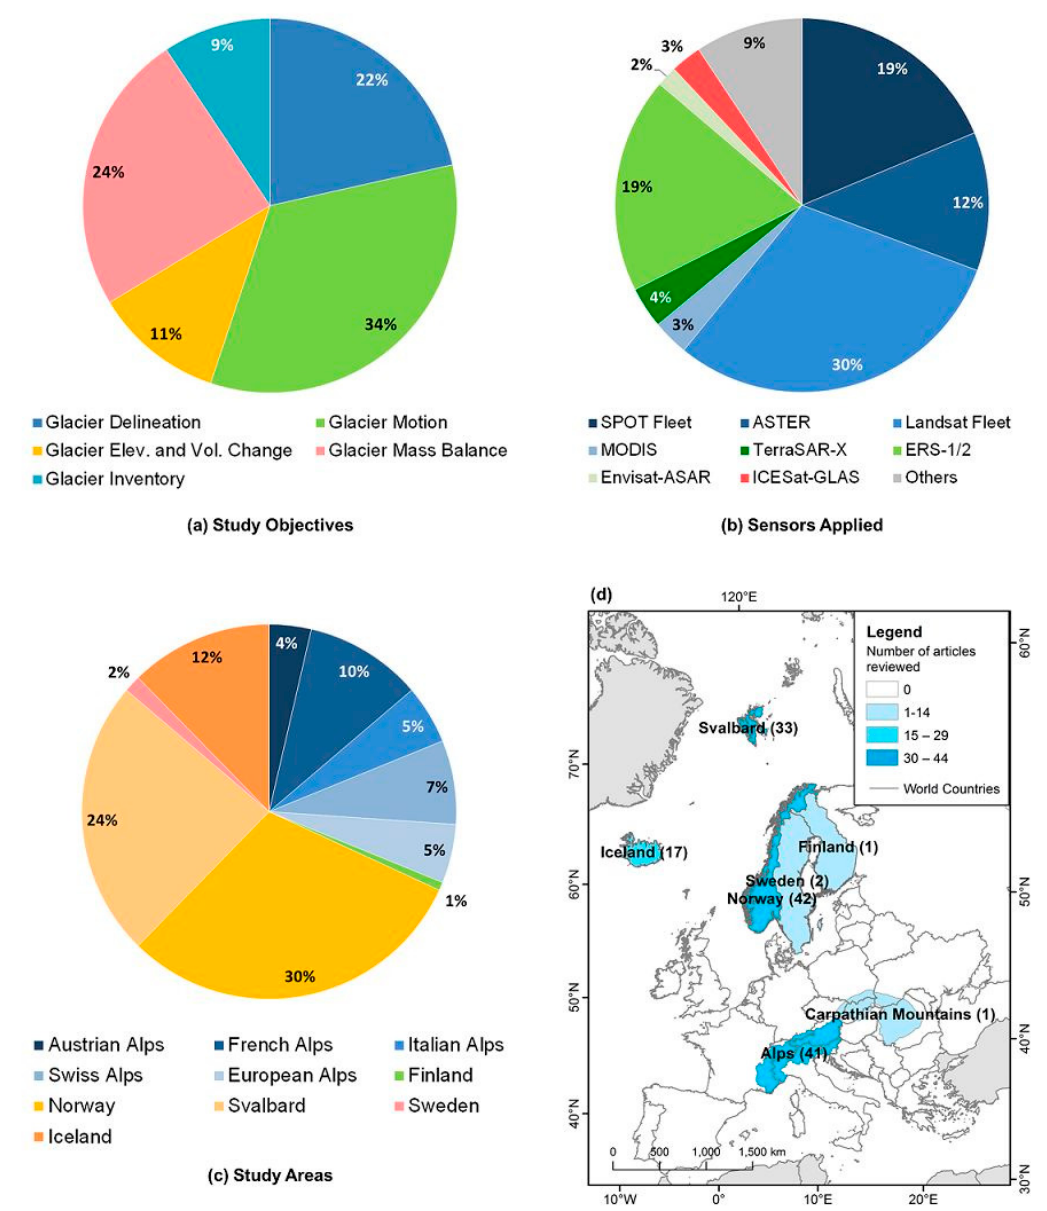
Figure 4. Overview of the reviewed EO-based glacier studies published between 1993 and 2017, categorized by ( a ) study objectives, ( b ) applied sensors (sensors used fewer than four times are shown in the class “others”, which includes ALOS-PALSAR, IKONOS, JERS-1 SAR, Pleiades, Sentinel-1,